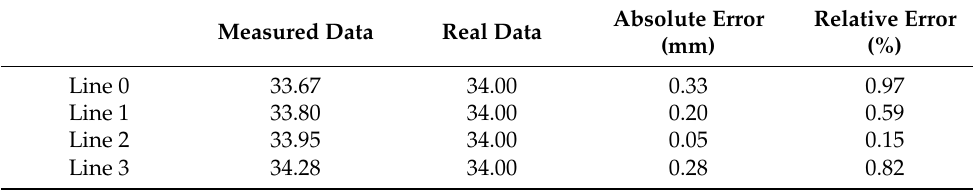
Table 3. Error between the measured and actual data of the inner diameter of the pipe.